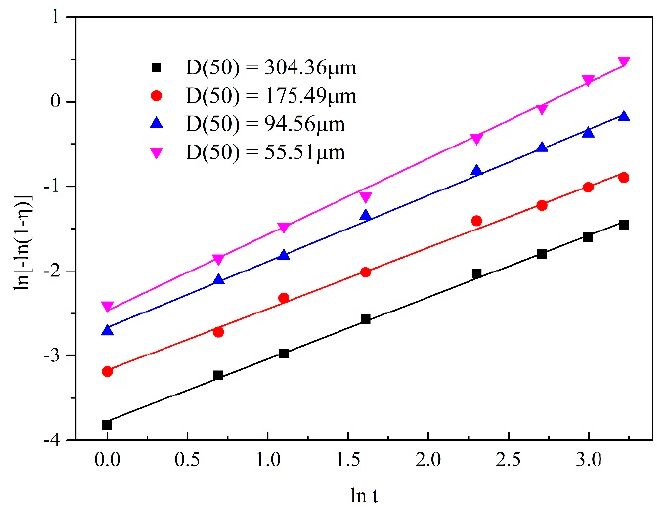
Table 2. Fitting results between ln[ − ln(1 − η )] and lnt under different particle size. Particle Size